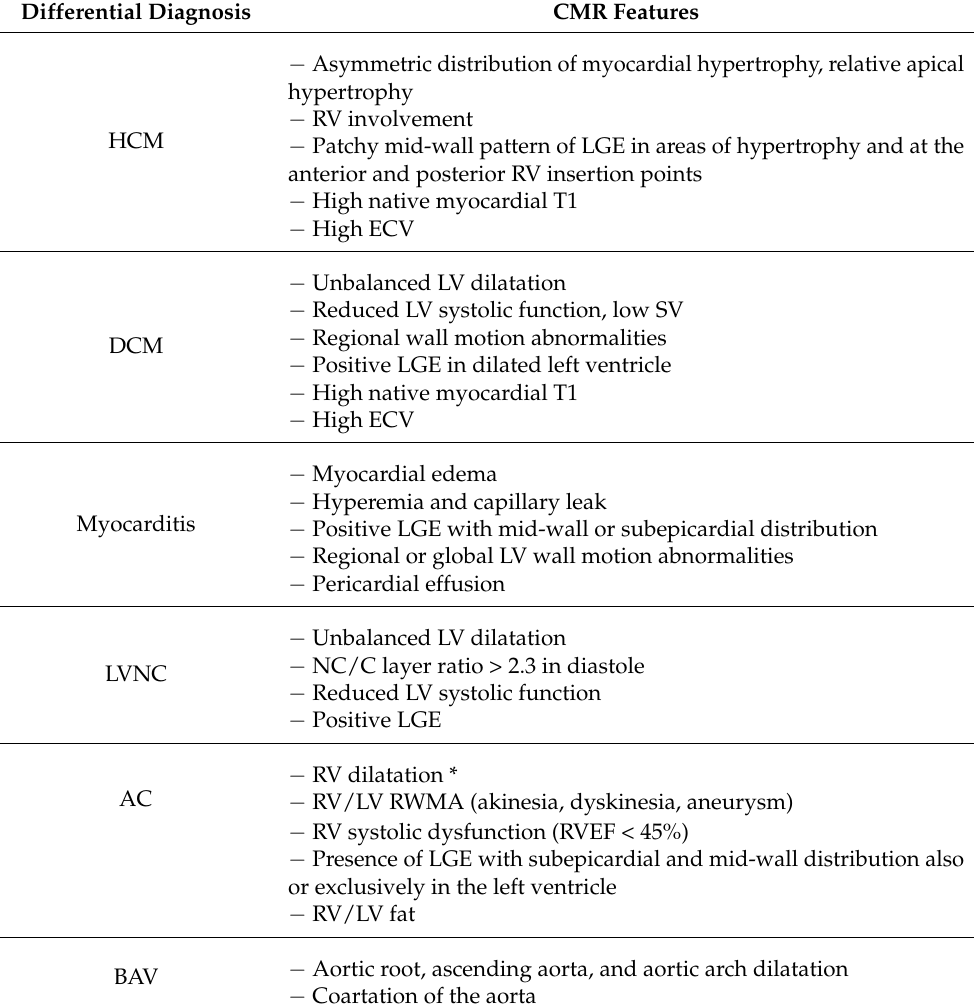
Table 3. Athlete’s CMR findings suggestive of cardiovascular